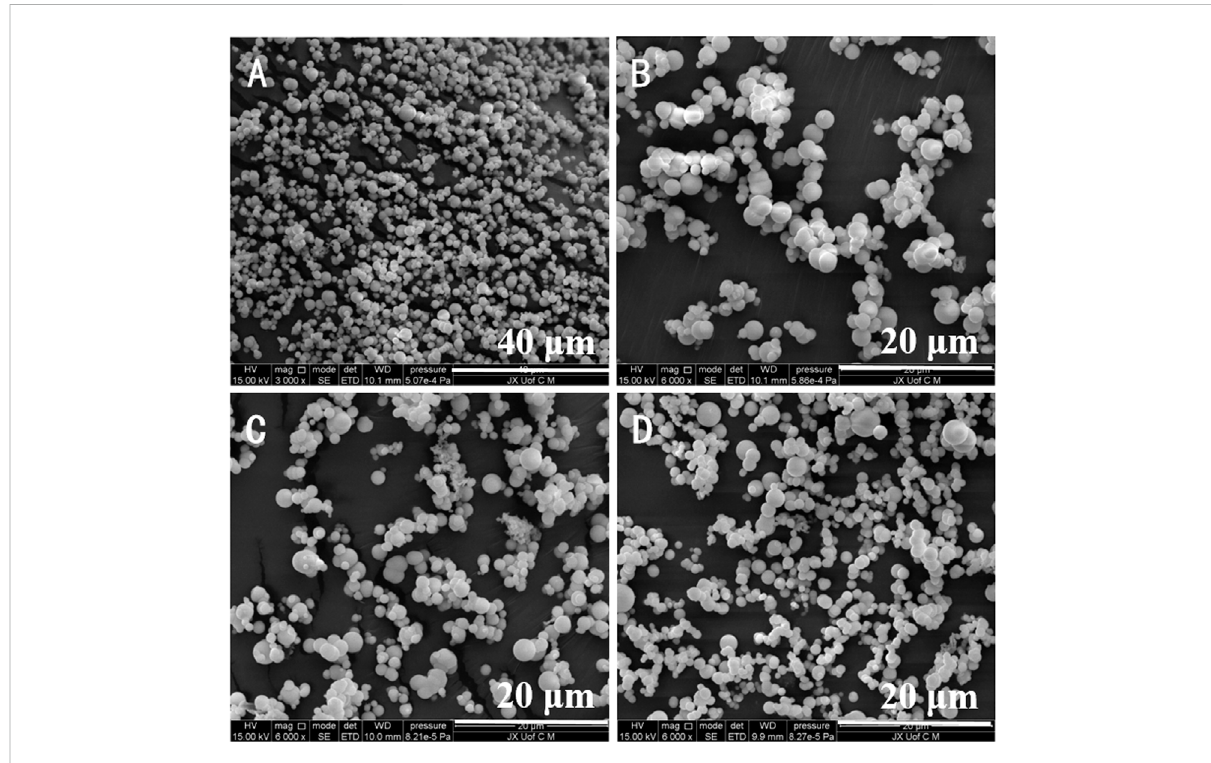
FIGURE 2 SEM images of Eu-CP-Ara micro/nanosphere after response time for 24 h (A,B) , 12 h (C) and 6 h (D) .